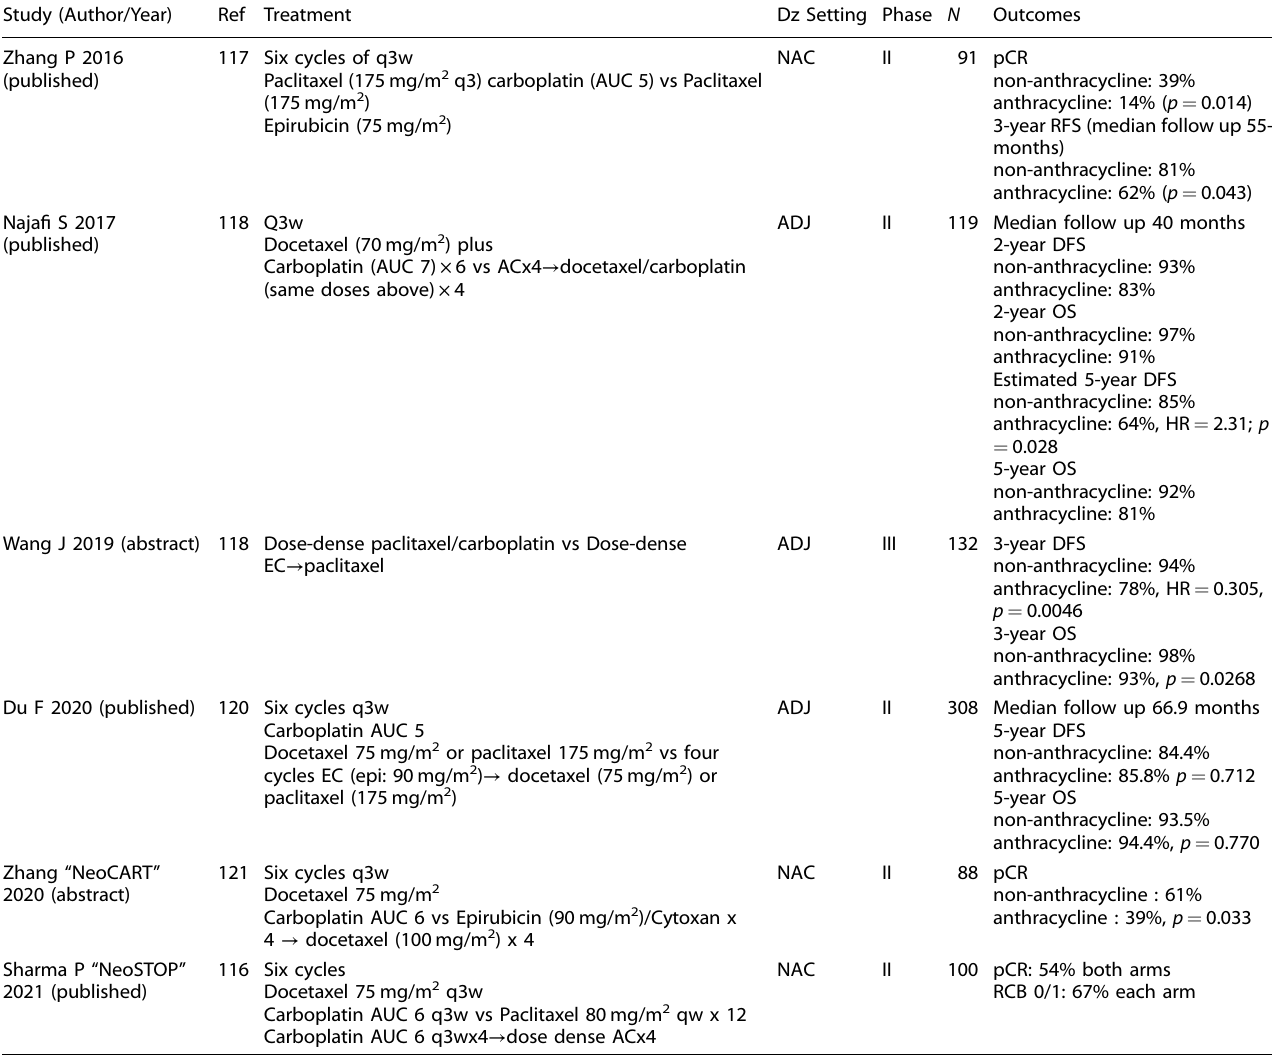
Table 4. Prospective randomized trials of taxane/platinum vs taxane/anthracycline in early triple-negative breast